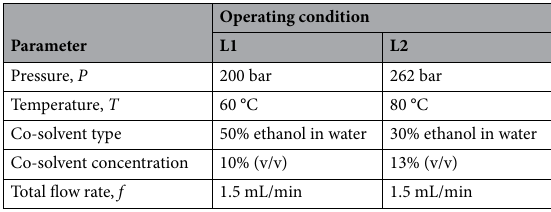
Table 2. Parameters used for L1 and L2 operating conditions.